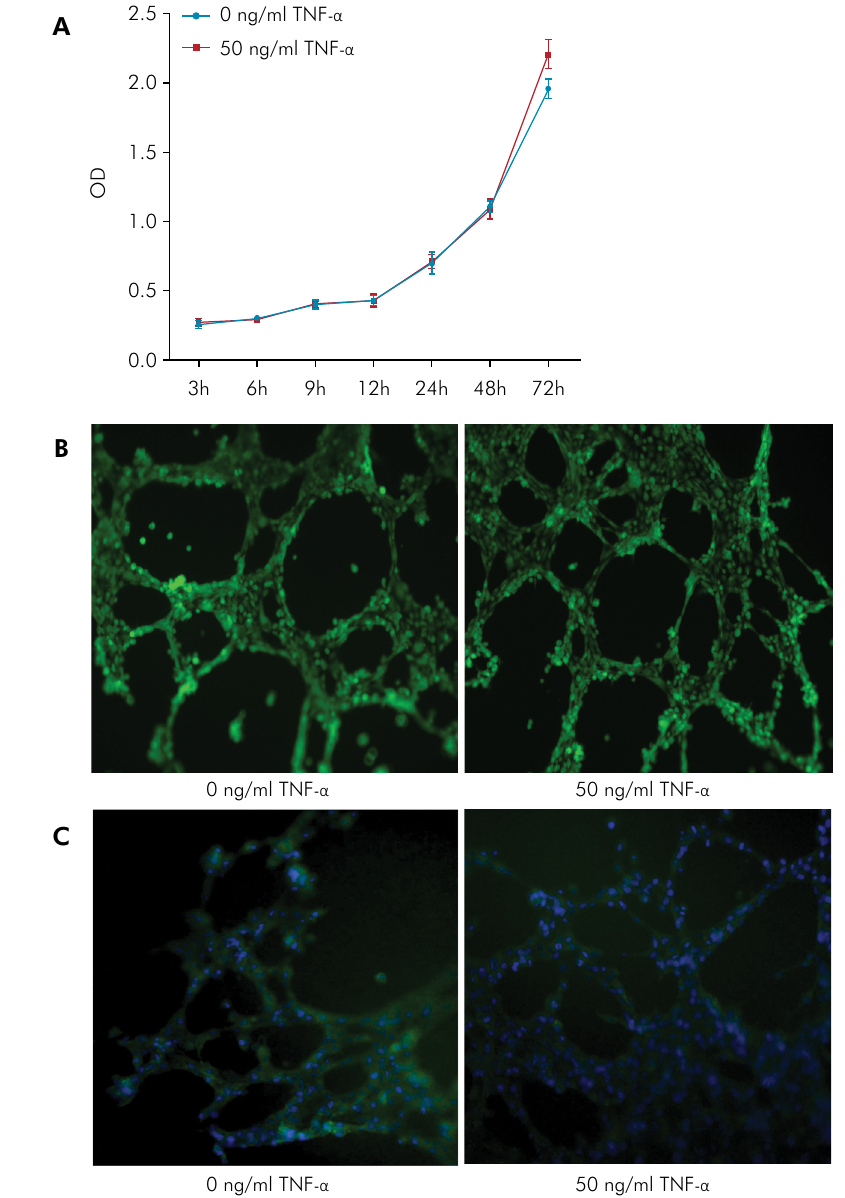
Figure 2. TNF- α had limited effects on the proliferation abilities of hDPSCs and HUVECs in the co-culture system. (A) The proliferation of hDPSCs and HUVECs was analyzed using Cell Counting Kit 8 at 3, 6, 9, 12, 24, 48, and 72 h under the action of 50 ng/ml TNF- α . OD values of the two groups of cells were comparable during the 8-day observation period. Data are presented as means ± standard deviations (error bars). (B) Live (green)/dead (red) staining of the lattice structures formed by the co-cultured system in the presence and absence of 50 ng/ml TNF- α . (C) CD31 (immunofluorescence)-stained vessel-like structures formed by HUVECs in co-culture. Green fluorescence indicates CD31 positivity, and blue staining indicates